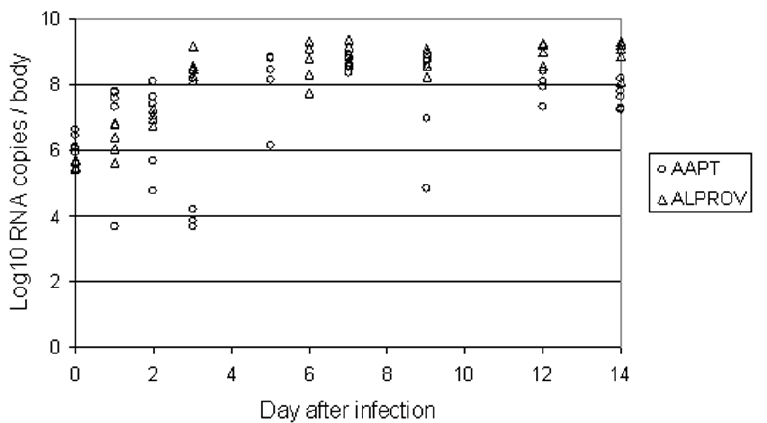
Figure 1. Infection of Aedesalbopictus Providence (ALPROV) and Aedesaegypti Petite-Terre (AAPT) with CHIKV 06.21. At different days after exposure to the infectious blood meal, mosquito infection was measured by detecting viral RNA in bodies (thorax and abdomen) of 5 females by real-time RT-PCR.